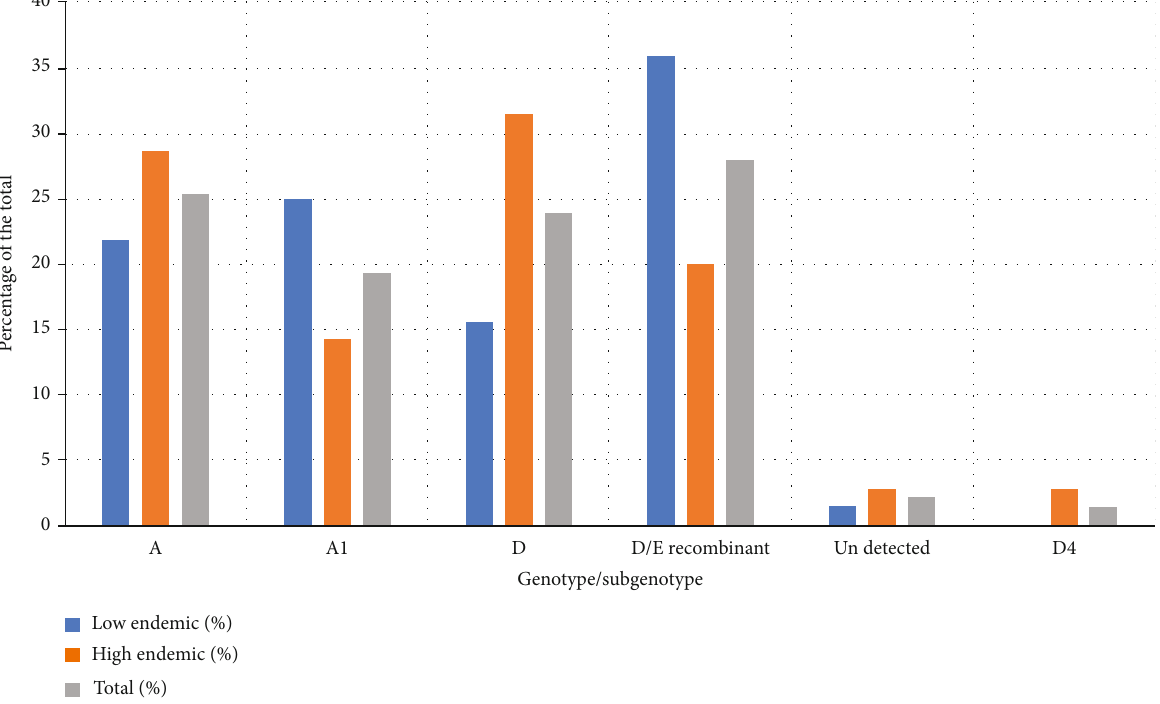
Figure 4: Relative proportion of the di ff erent genotypes and subgenotypes in the low and high endemic regions of Uganda. Table 3: Multilevel analysis of genotype distribution in the low and high endemic regions using multinomial regression analysis.